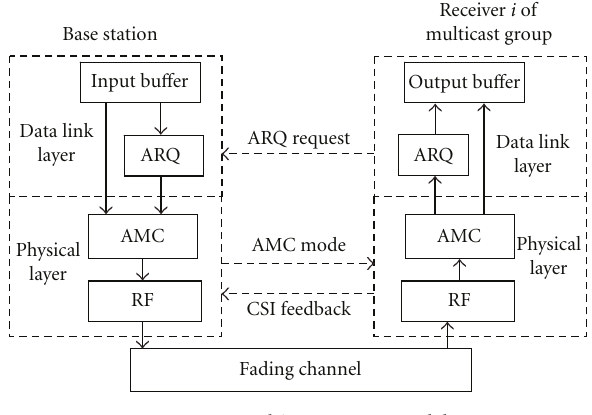
Figure 1: Multicast system